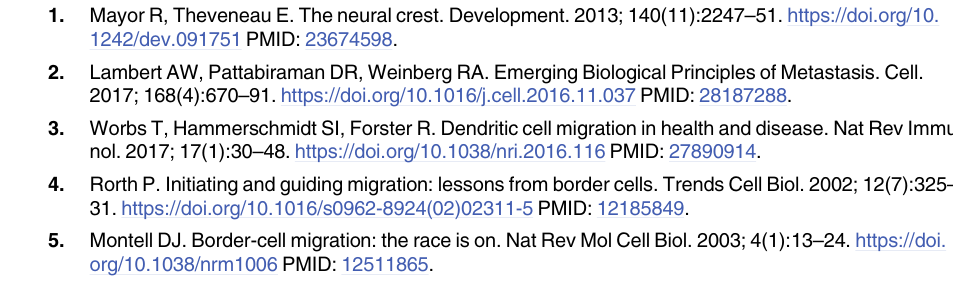
S2 Fig. Border cell migration degrees caused by RNAi or transgene expressions with c306-Gal4 . (A-G) Stage 10 egg chambers of labeled genotypes show the c306-Gal4 expression patterns by GFP (Green). The arrows show the positions of the border cell clusters. (H) Quan- titation of border cell migration. The x-axis denotes the percentage of stage 10 egg chambers for each genotype with each degree of migration. The extent of migration for all stage-10 egg chambers examined is measured as 0–5% (blue, no migration), 6–25% (yellow), 26–50% (pink), 51–75% (green), 76–100% (black, complete migration). The number of egg chambers examined for each genotype is given (n). Expression of PA RNAi driven by c306-Gal4 disrupts border cell migration, but expression of PB or PC/PD RNAi did not affect border cell migra- tion. Expression of PA also disrupts border cell migration and can rescue the migration defect caused by PA RNAi